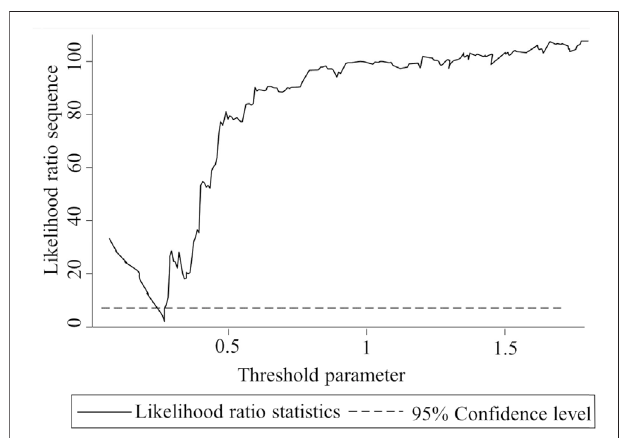
FIGURE 1 | Threshold estimated likelihood